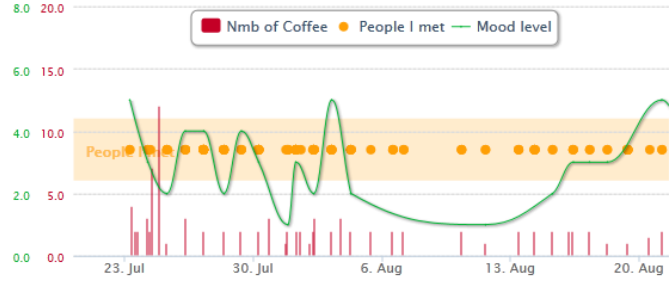
Figure 15. Example of Multiviz Data Stream Infographing Available on the Sen.se